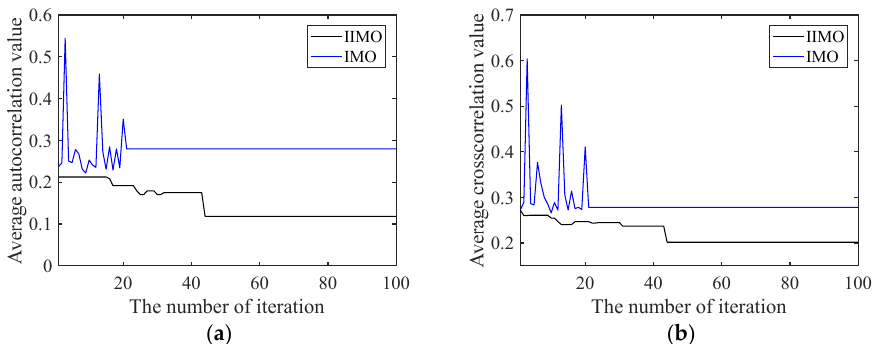
Figure 1. ( a ) Average autocorrelation comparison between improved ions motion optimization (IIMO) and ions motion optimization (IMO) under L = 4 and N = 40, ( b ) Average cross-correlation comparison between IIMO and IMO under L = 4 and N = 40.